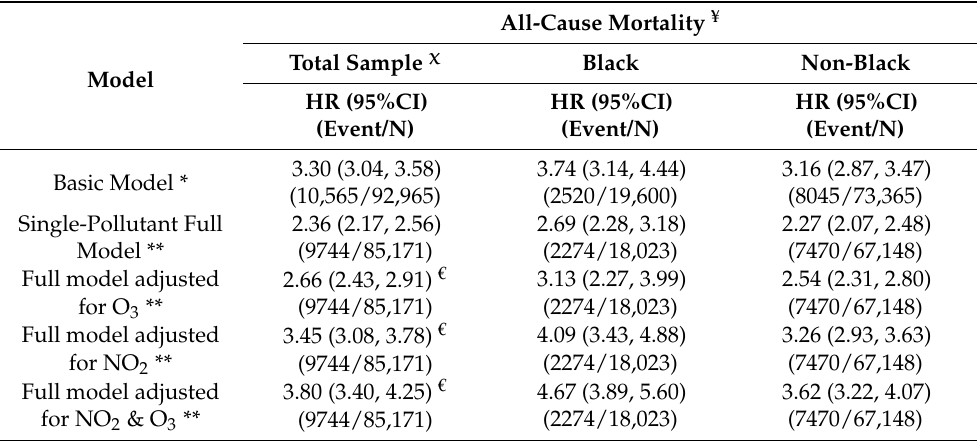
Table 2. Multivariable-Adjusted Hazard Ratios for All-cause Mortality per 10 µ g/m 3 Increment of PM 2.5 : Single-Pollutant and Multi-Pollutant Models by